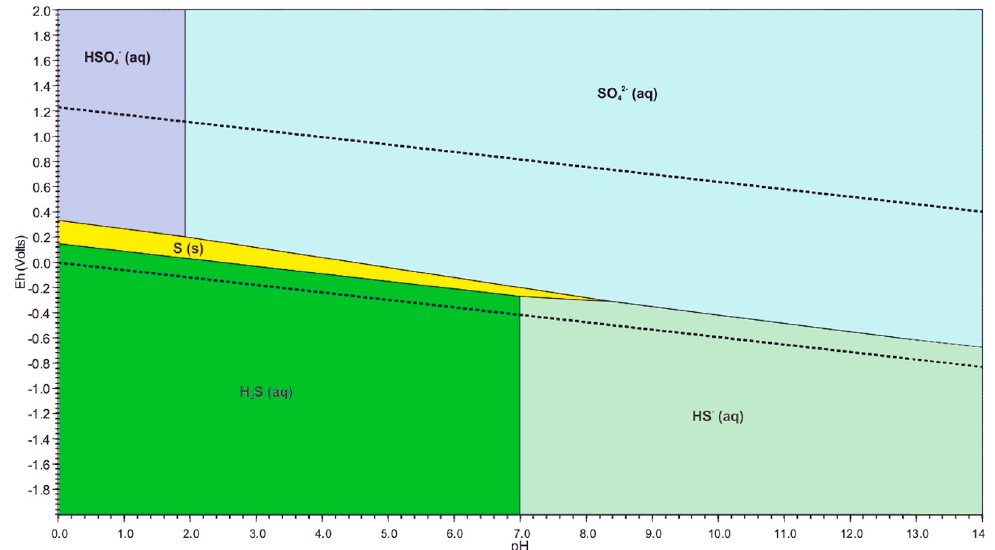
Figure 2. Eh-pH graph of hydrolysis speciation of sulphate and sulphide [15].